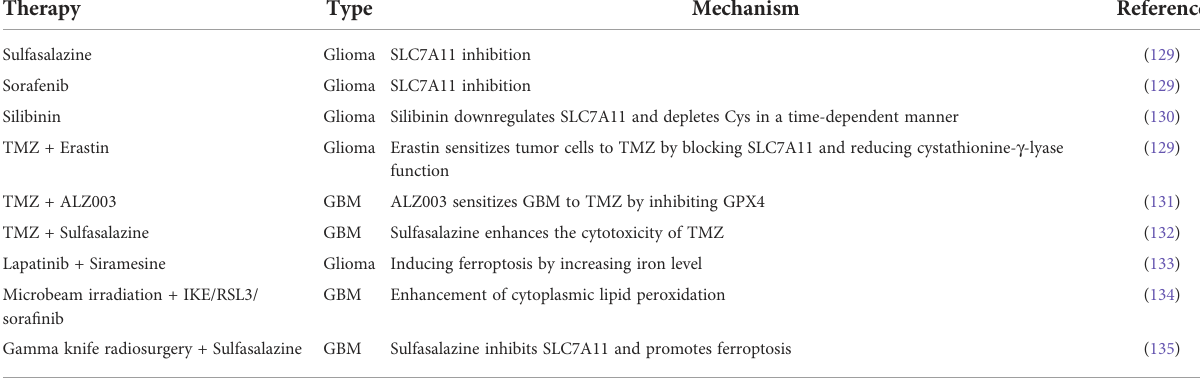
TABLE 1 The promising applications of ferroptosis in the treatment of glioma. Therapy Type